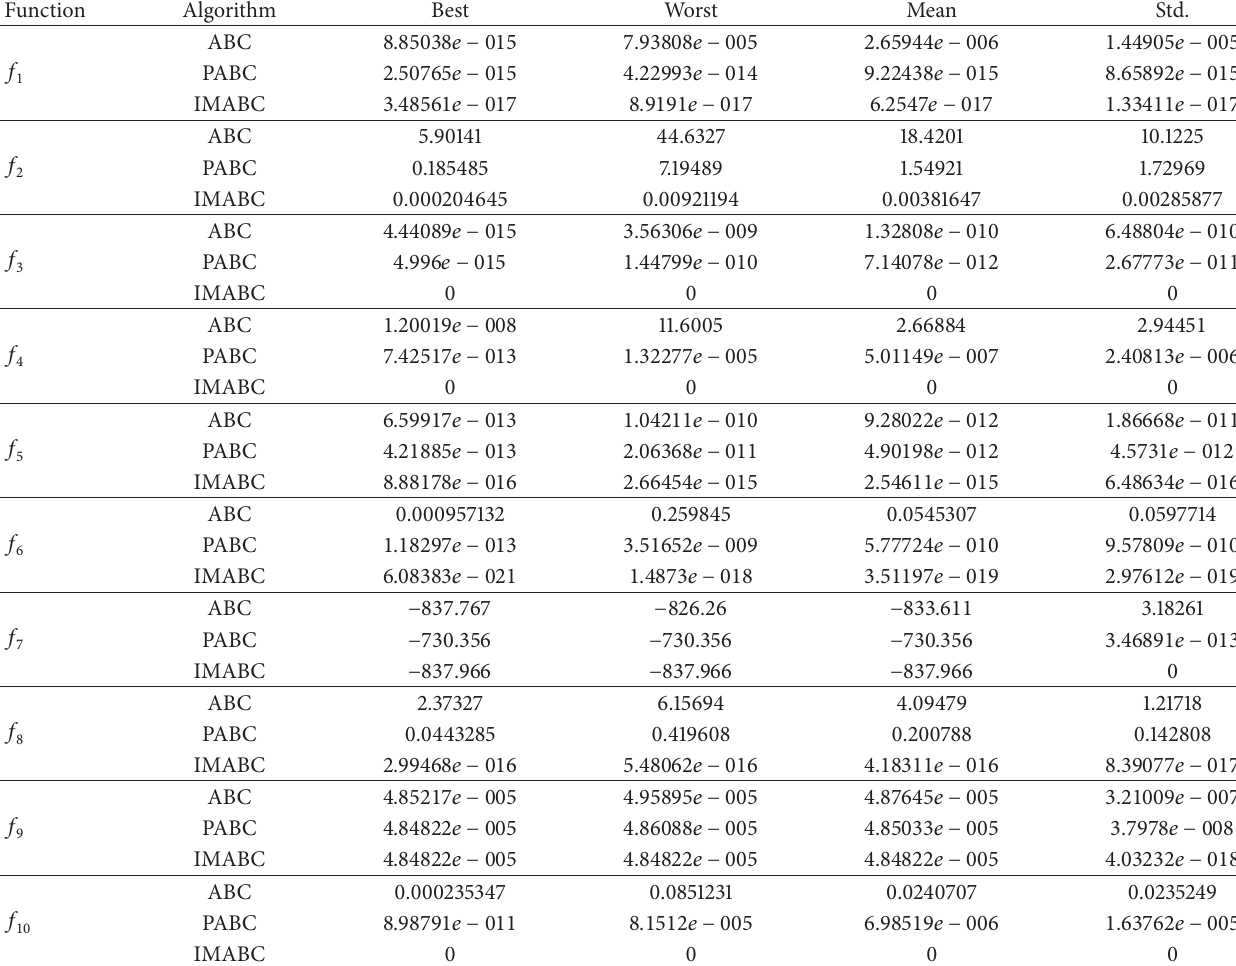
Table 2: Results comparison of 10 test functions of 3